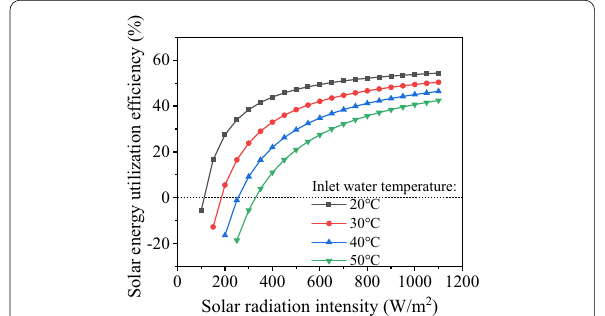
Fig. 9 Effect of solar radiation intensity on solar energy utilization